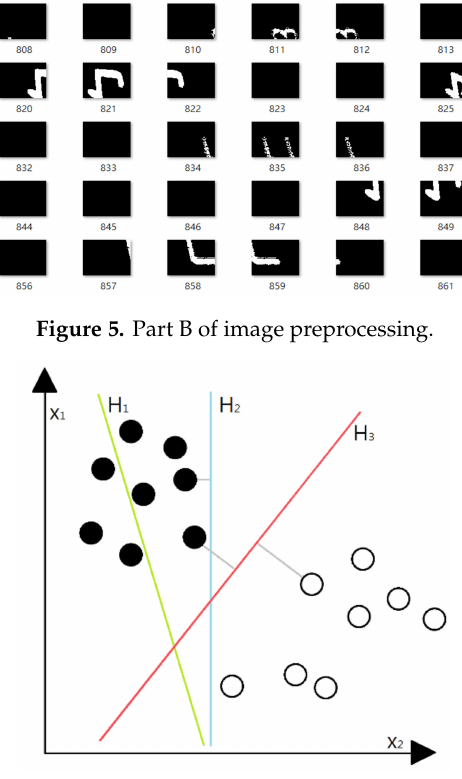
Figure 6. Classification of the support vector machine